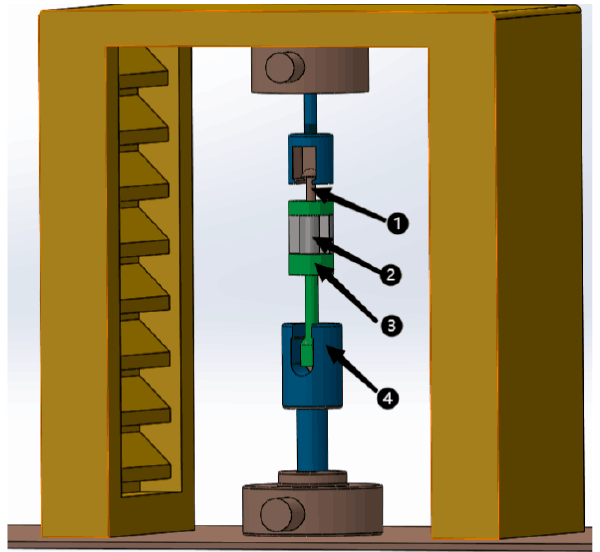
Figure 2. Tensile test device. 1—M12 × 1.25 screw; 2—Magnesium alloy; 3—Special tooling; 4—Cupping machine.